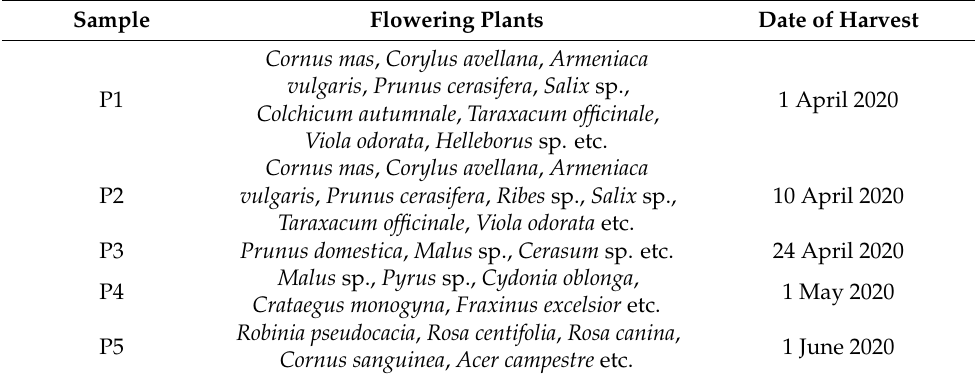
Table 1. Origin of bee pollen